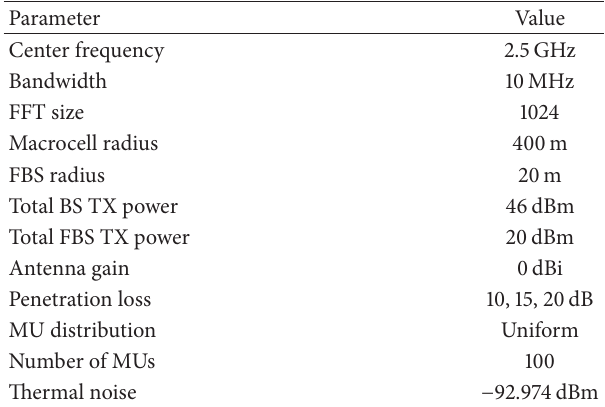
Table 4: System parameter for